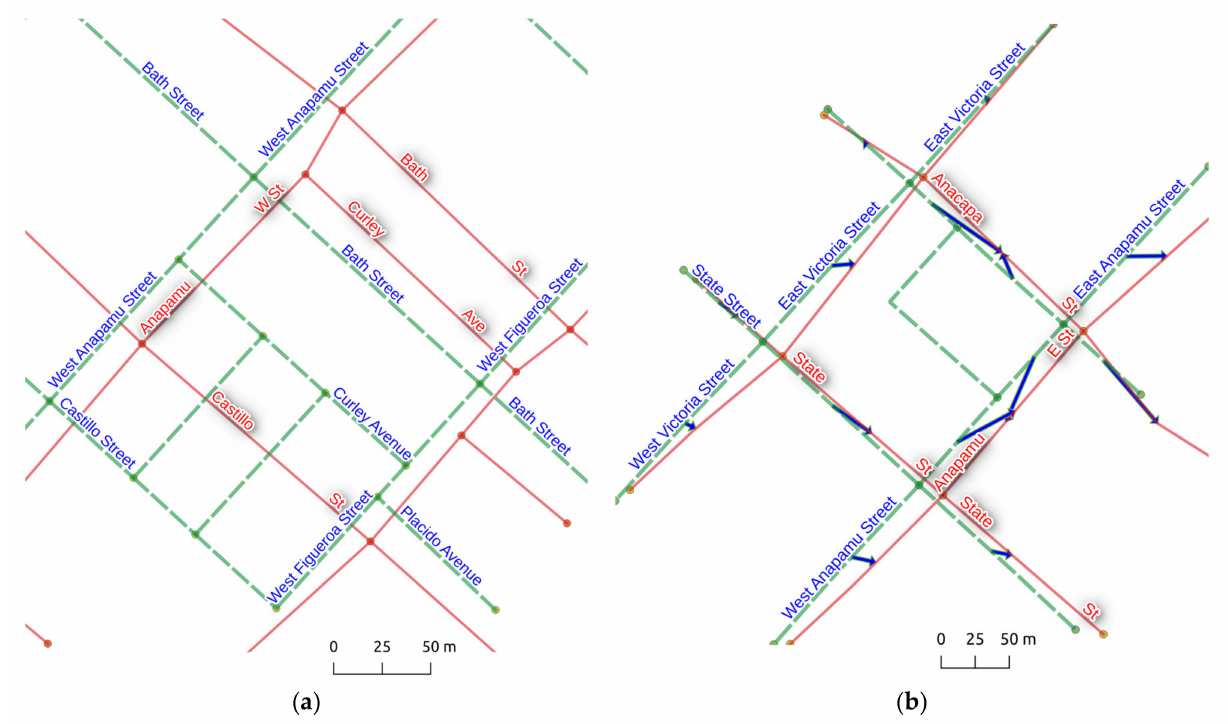
Figure 1. Conflation issues with OpenStreetMap (green) and TIGER (red) networks in downtown Santa Barbara, CA. Blue arrows represent matches. ( a ) Spatial offsets defeat spatial joins; ( b ) full and partial matches in a street